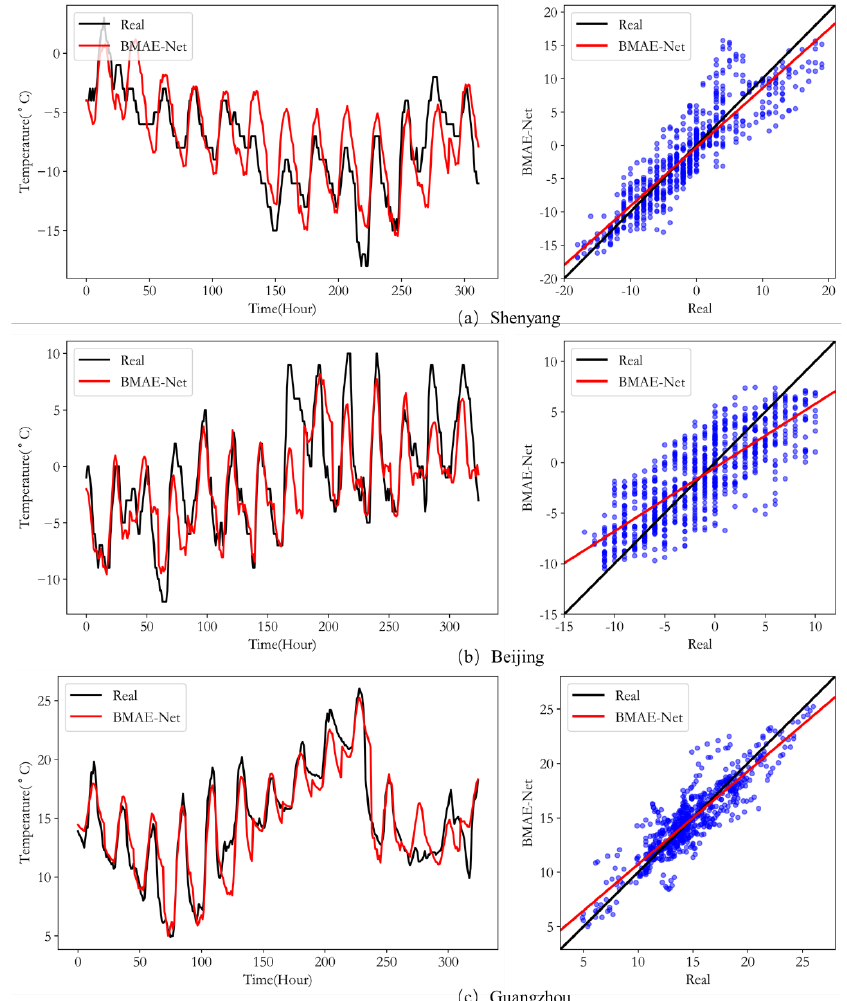
Figure 9. Comparison of each location’s actual and predicted temperatures in Case 1.